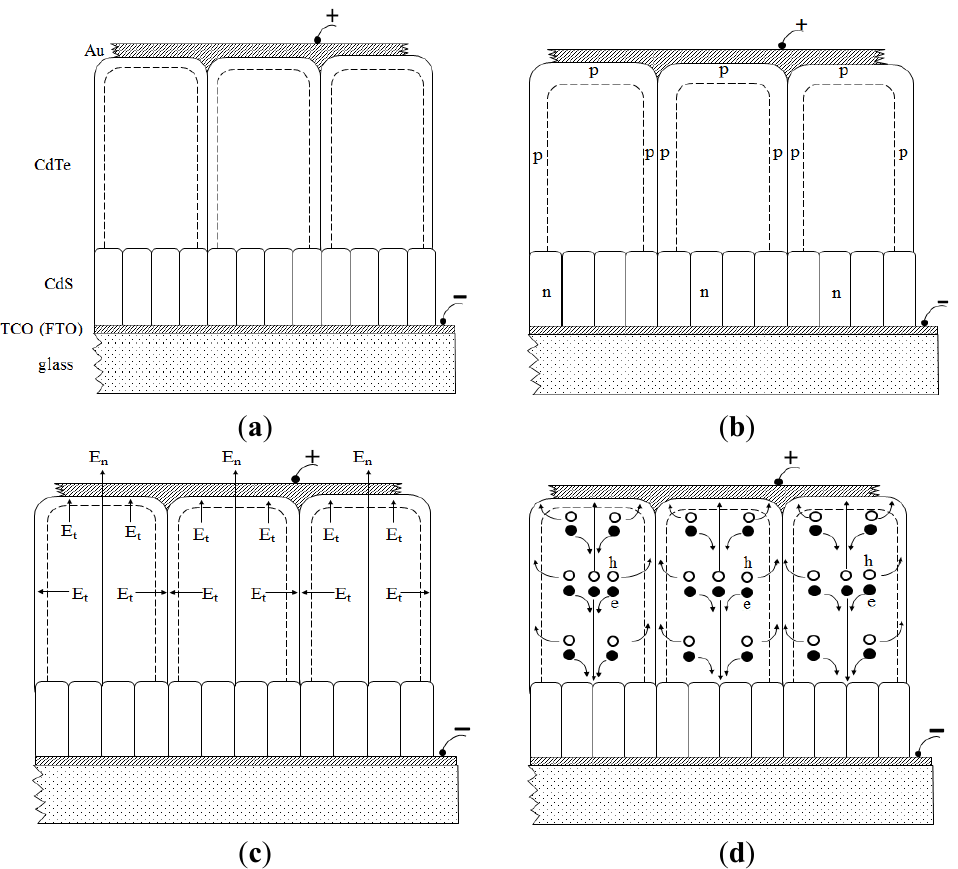
Figure 24. Schematic diagram of ( a ) rod-type CdS/CdTe solar cells; ( b ) doping effects of grains after CdCl treatment; ( c ) presence of local electric fields ( E 2 electric field ( E ) within the device; and ( d ) photo-generated charge carrier separation and n collection with high current densities along grain